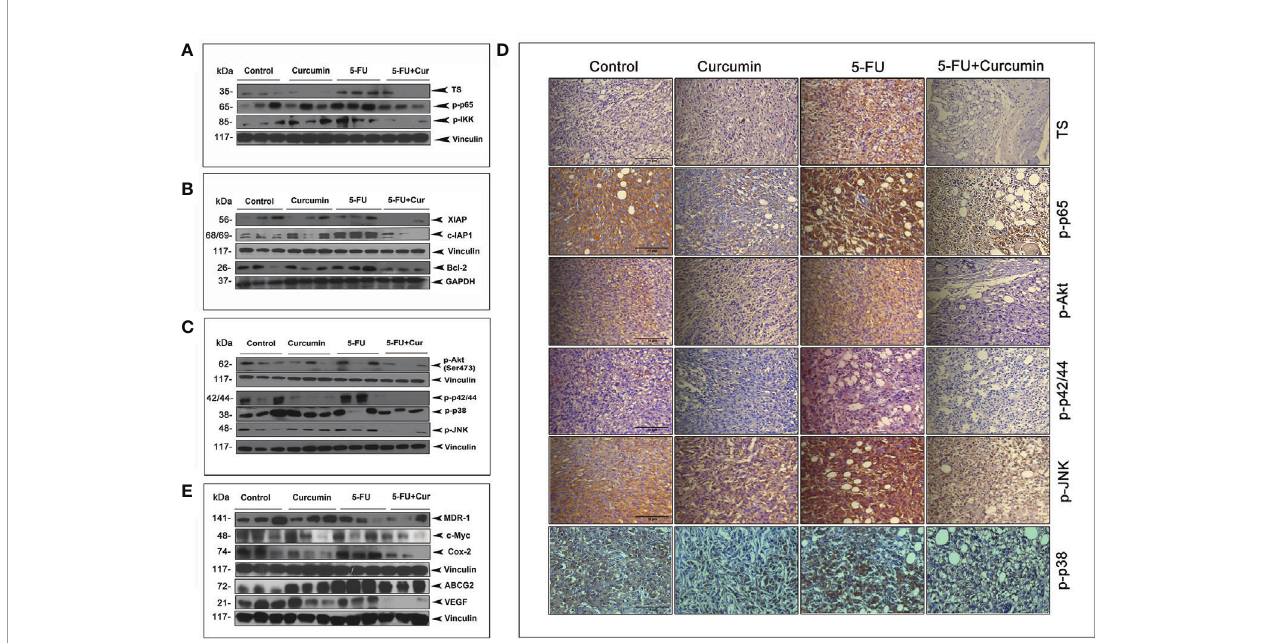
FIGURE 3 | Curcumin attenuates 5-FU-induced over-expression of TS together with activation of NF- k B and other major survival signals. (A) Treatment with 5-FU alone induced a signi fi cant over-expression of TS and activation of NF- k B and IKK, which was remarkably down-regulated by curcumin pre-treatment. Total proteins were extracted from tumor samples and were subjected to Western blot analysis using speci fi c antibodies against TS, p-p65, and p-IKK. (B) Curcumin pre- treatment down-regulates 5-FU induced up-regulation of XIAP, c-IAP1, and Bcl-2. All experiments were repeated thrice with samples from different animals of the same treatment groups. Vinculin and GAPDH levels demonstrate equal loading of samples. (C) Curcumin pre-treatment remarkably suppressed 5-FU-induced activation of Akt and MAPKs. (D) Immunohistochemical analysis of the expression status of TS and p65 subunit of NF- k B, p-Akt, p-p42/44 and p-JNK in tumor tissue sections from experimental groups. (E) Curcumin pre-treatment down-regulates 5-FU-induced over-expression of MDR-1, c-Myc, Cox-2, ABCG2 and VEGF in human BC xenografts. All experiments were repeated thrice with samples from different animals of the same treatment groups. Anti-Vinculin immunoblot serves as the loading